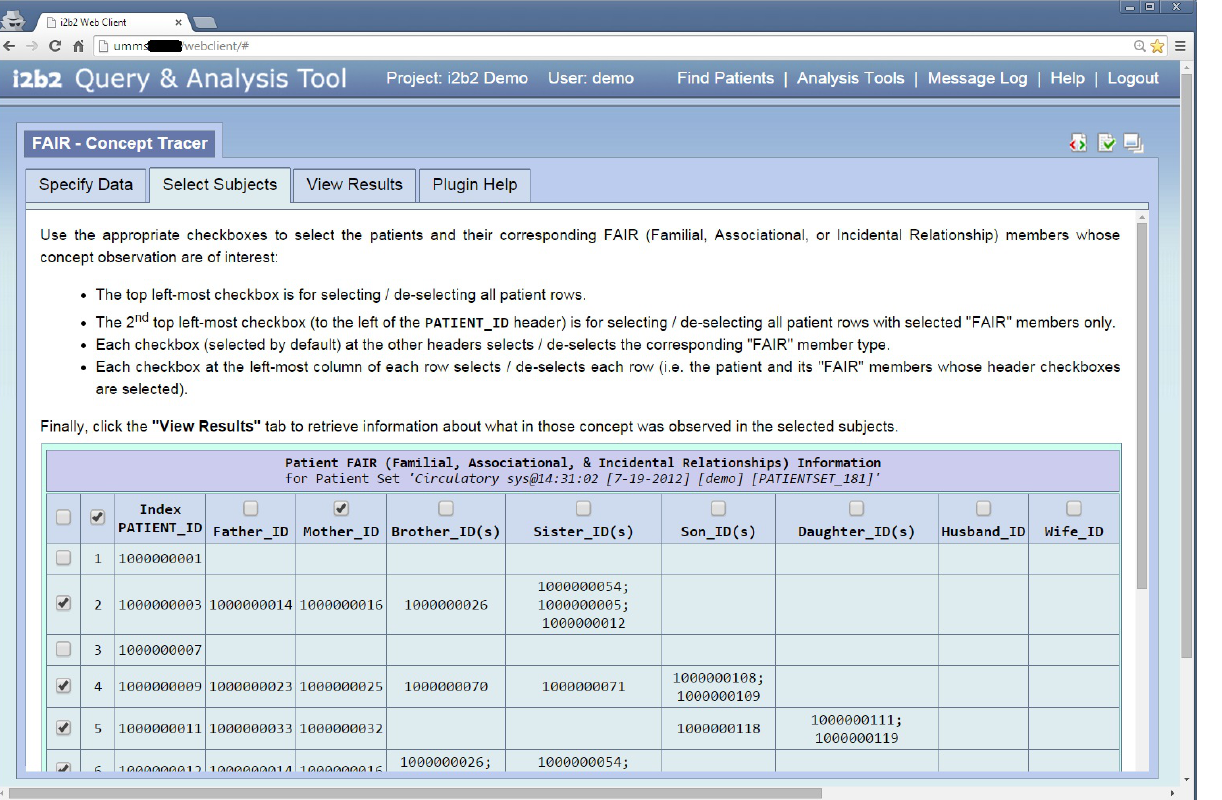
Figure 3. Select Subjects window for the FAIR Concept